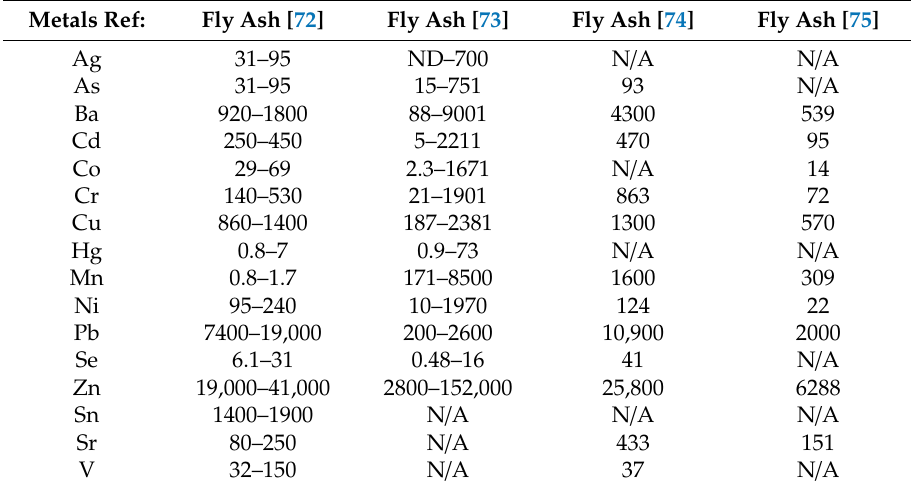
Table 4. Heavy metal content (mg / kg) in MSWI fly ash (FA).